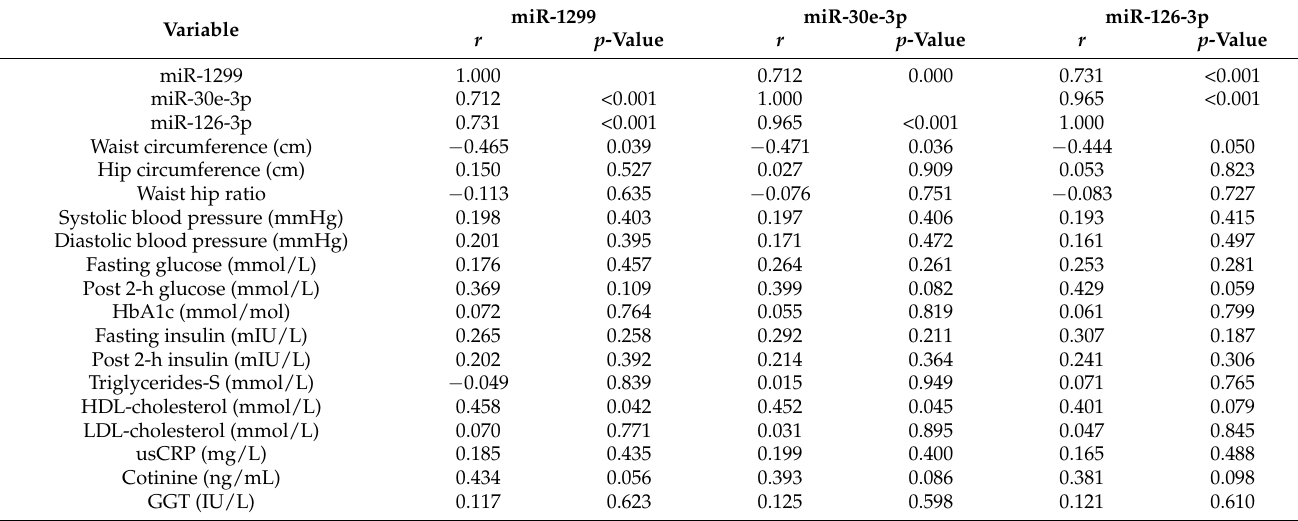
Table 3. Partial Spearman’s correlation coefficients adjusted for age, sex and body mass index (BMI).